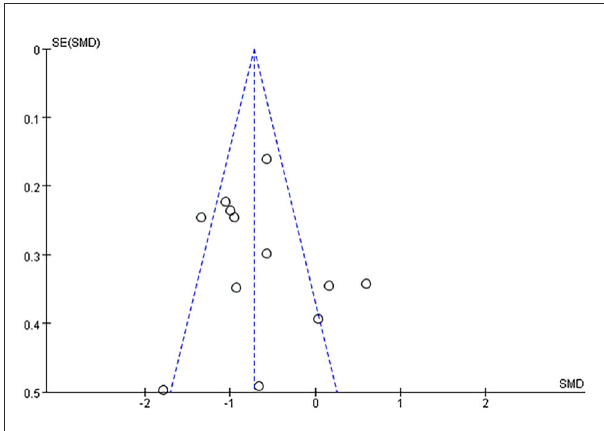
FIGURE5 Funnel plot of the included studies on